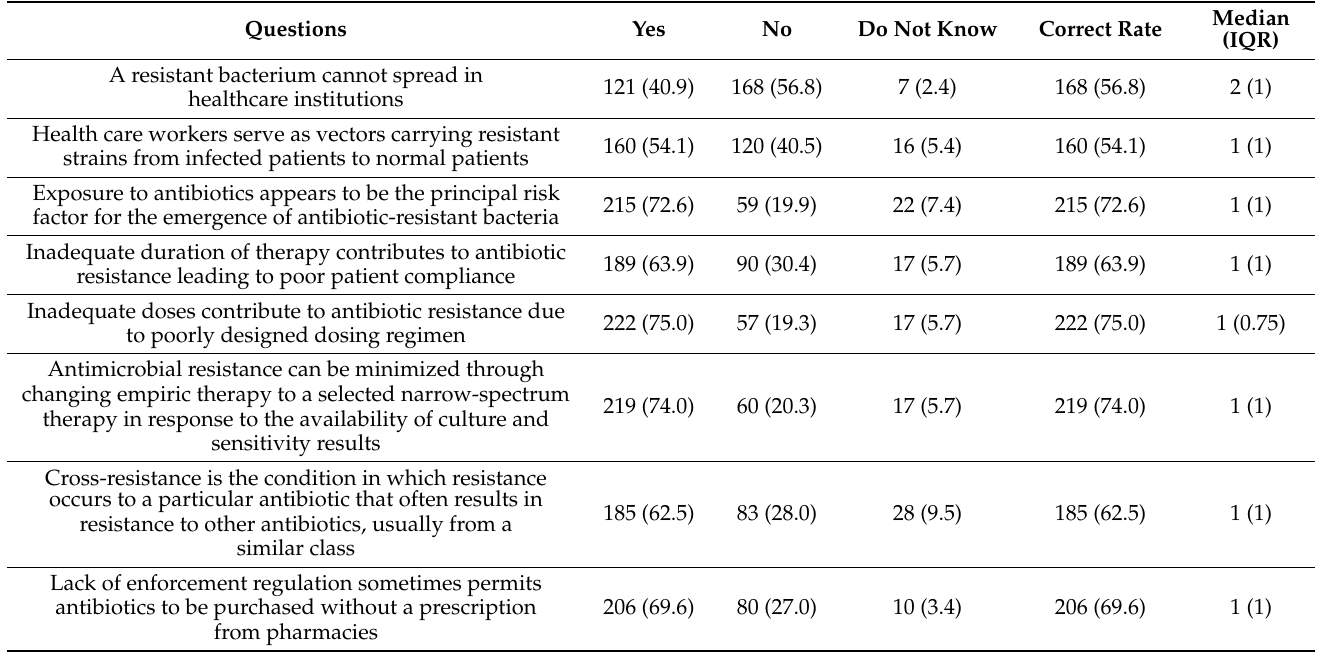
Table 3. Understanding about antibiotic resistance use n (%).